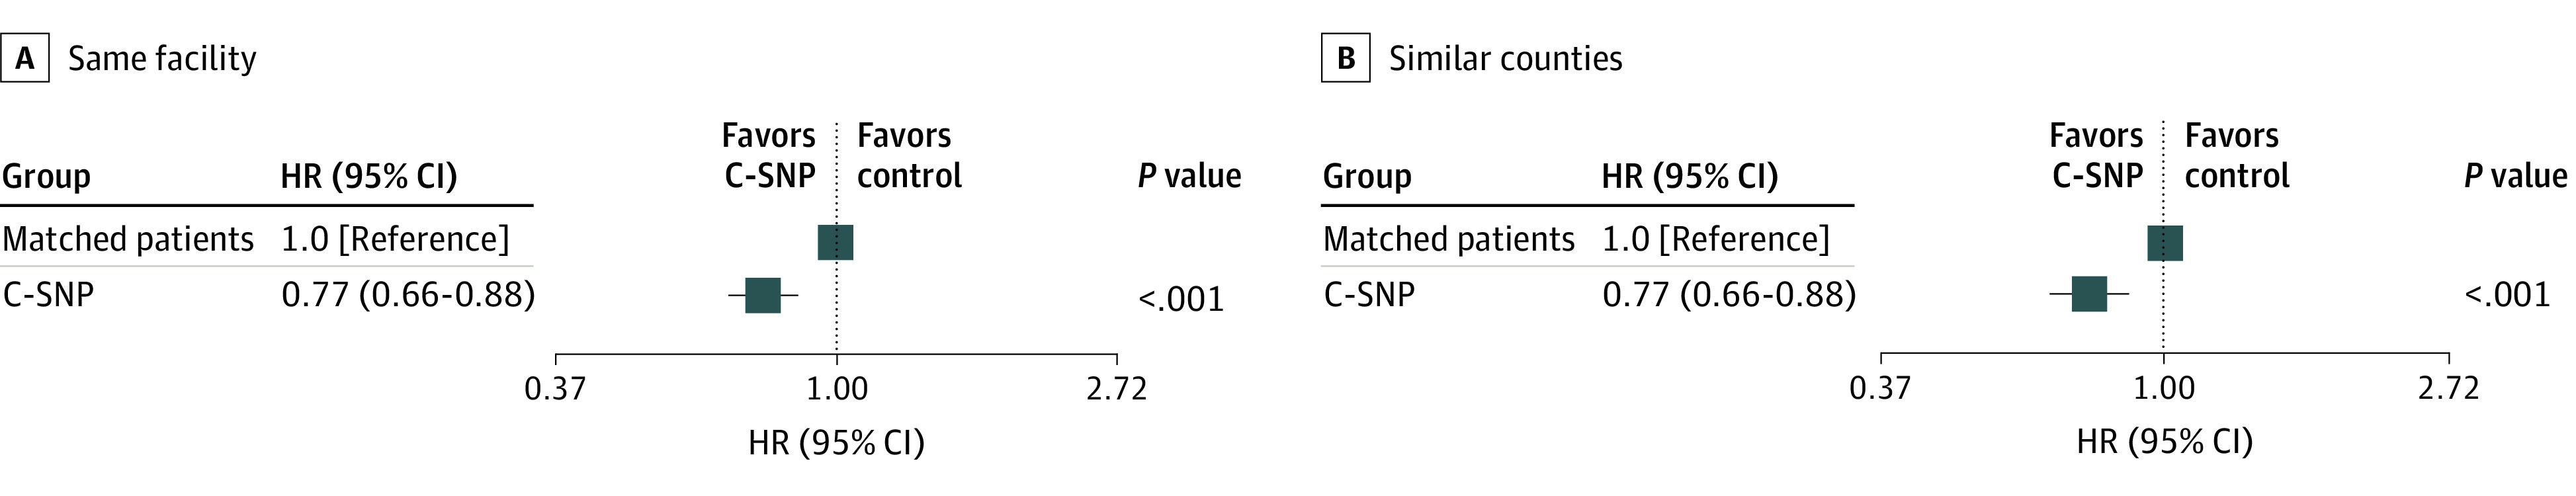
Mortality Among Chronic Condition Special Needs Plan (C-SNP) Enrollees and Matched Patients Across Same Facility and Similar CountiesHR indicates hazard ratio.